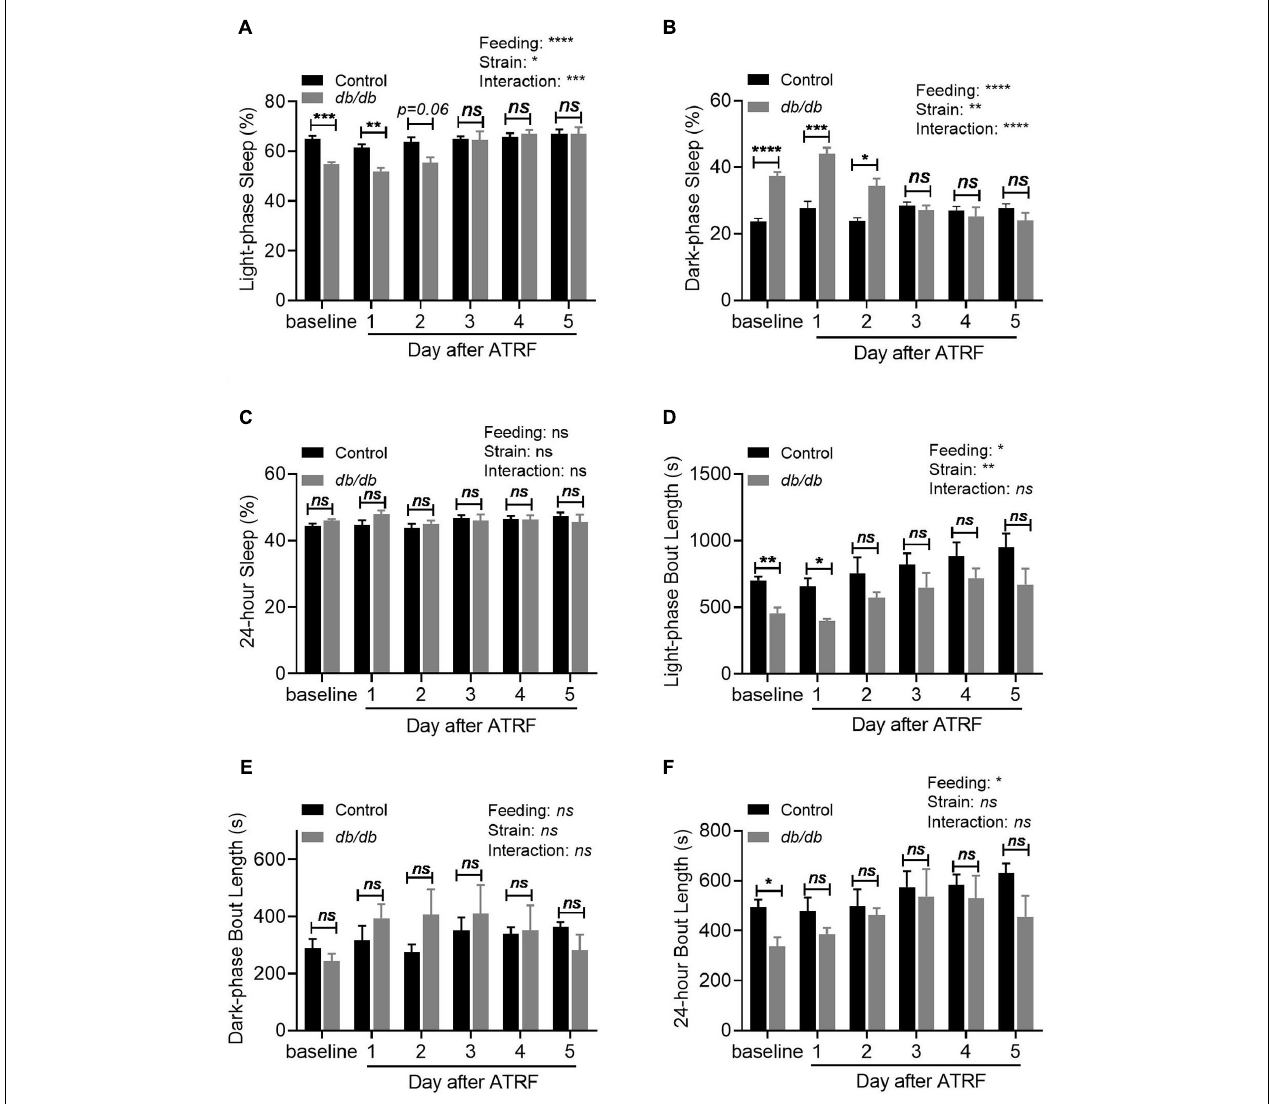
FIGURE 2 | Quantification of the sleep-wake profile of the control and db/db mice with ALF and the 1–5 days of ATRF. (A–C) Average sleep time percent during the light-phase (A) , dark-phase (B), and over 24-h (C) . (D–F) Average sleep bout length during the light-phase (D) , dark-phase (E) , and over 24-h (F) . Control, n = 6–8; db/db , n = 6–7. ∗ p < 0.05; ∗∗ p < 0.01; ∗∗∗ p < 0.001; ∗∗∗∗ p < 0.0001; ns , no significant.